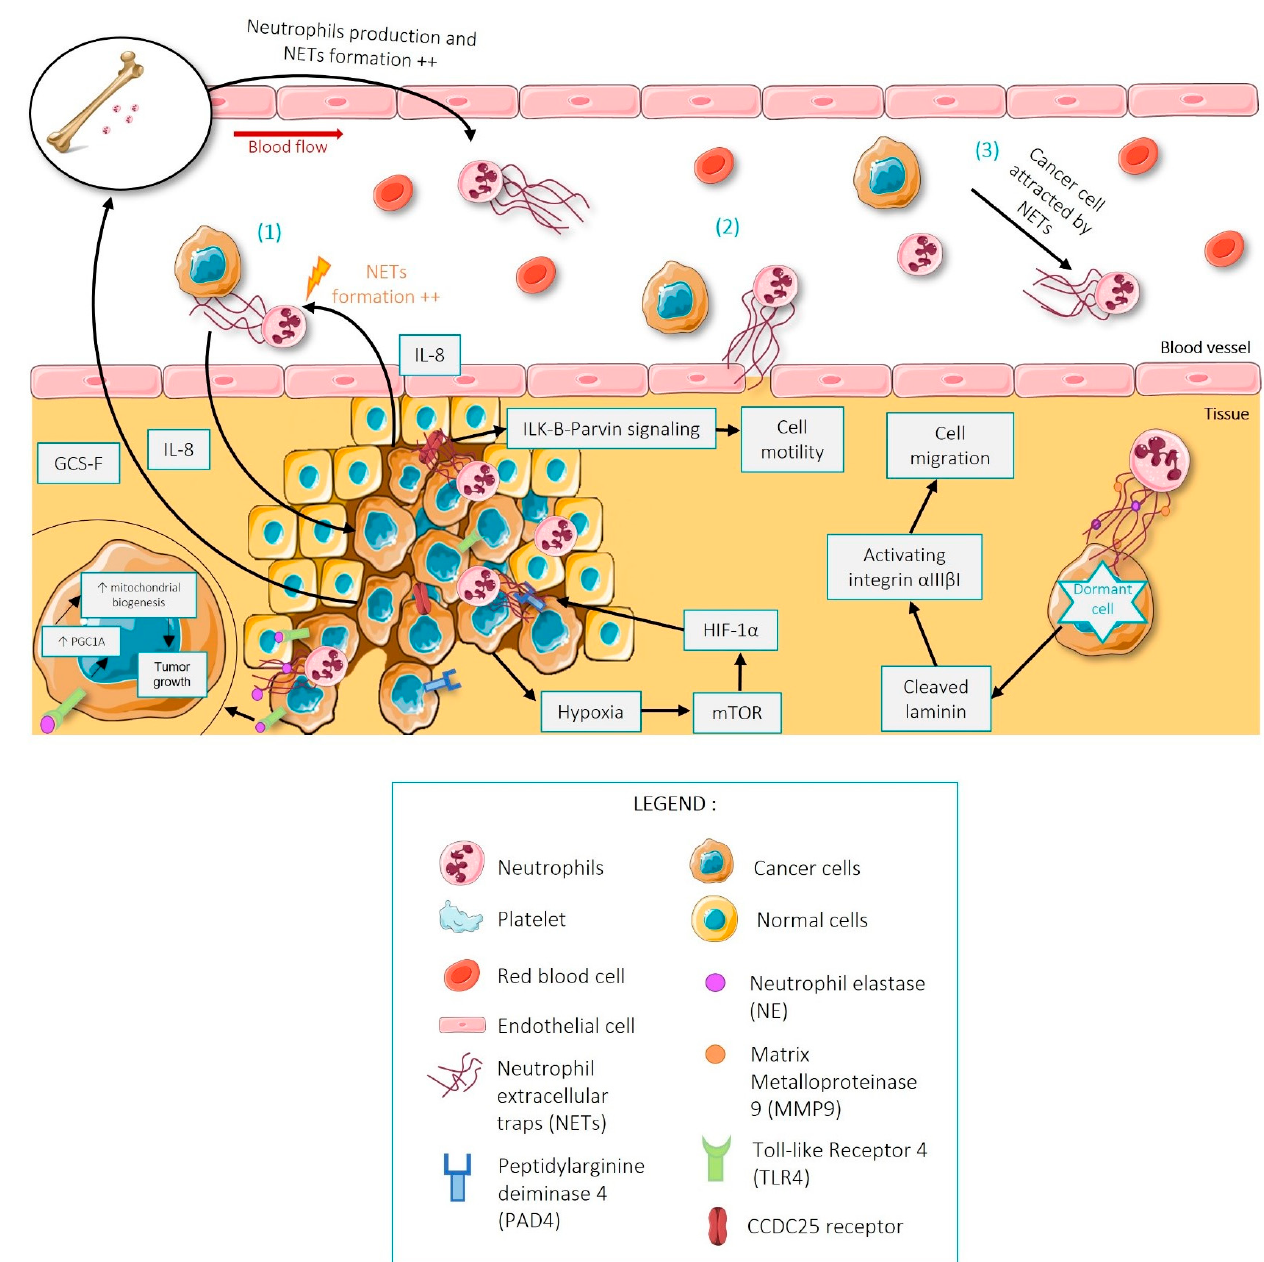
Figure 4. Schematic representation of the 3 main hypotheses of NETs in cancer (1) DNA network formed by NETs may trap circulating cancer cells at the site of dissemination. (2) DNA network formed by NETs may increase local vascular permeability that facilitates the extravasation of cancer cells into the surrounding tissues. (3) The extracellular DNA represented by NETs can act as a chemotactic factor to attract cancer cells. Figure created using Servier Medical Art available at http://smart.servier.com/ (accessed on 15 September 2021).